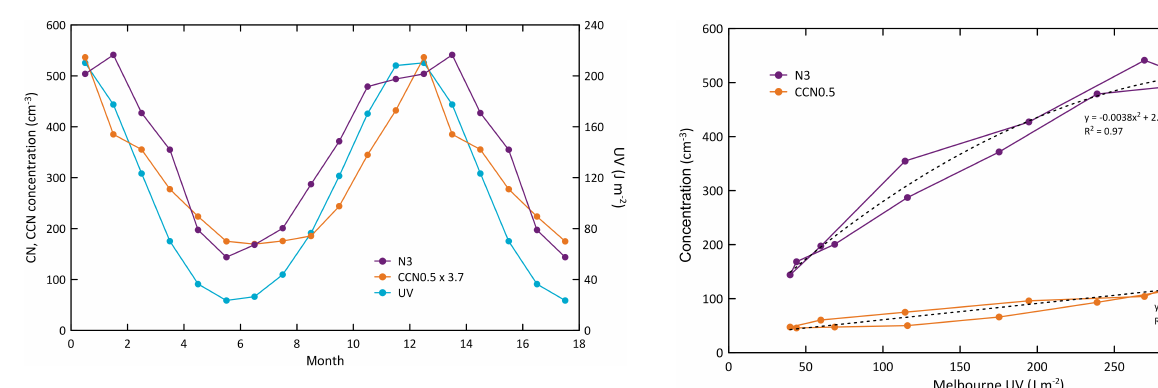
Figure 6. Seasonal variation in N3 (1978–2005) and CCN0.5 (1981–2006) with radon <150mBeqm − 3 , and UV (1978–2005). N3 and CCN are monthly medians with 12 months of data plotted as 18 months; summer is months 1, 2, 12 (13, 14). CCN concentra- tions are scaled ( × 3.7) to give a similar plotted amplitude range to N3.